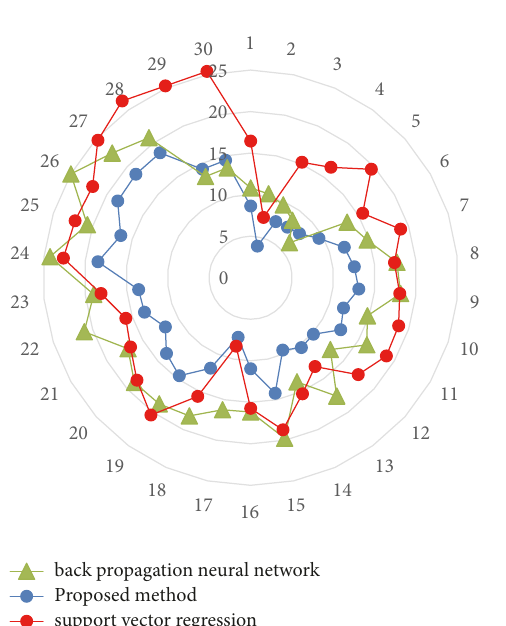
Figure 10: Prediction results of 30 steps for weekend reliability based on different